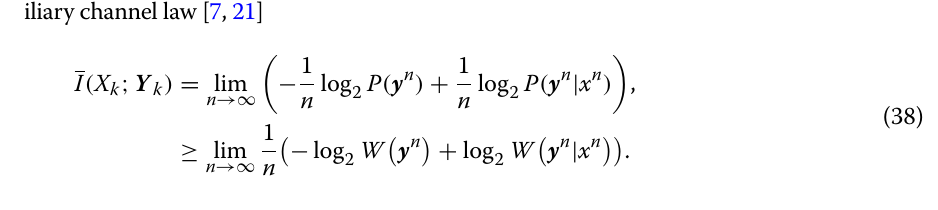
3 , generator polynomial =